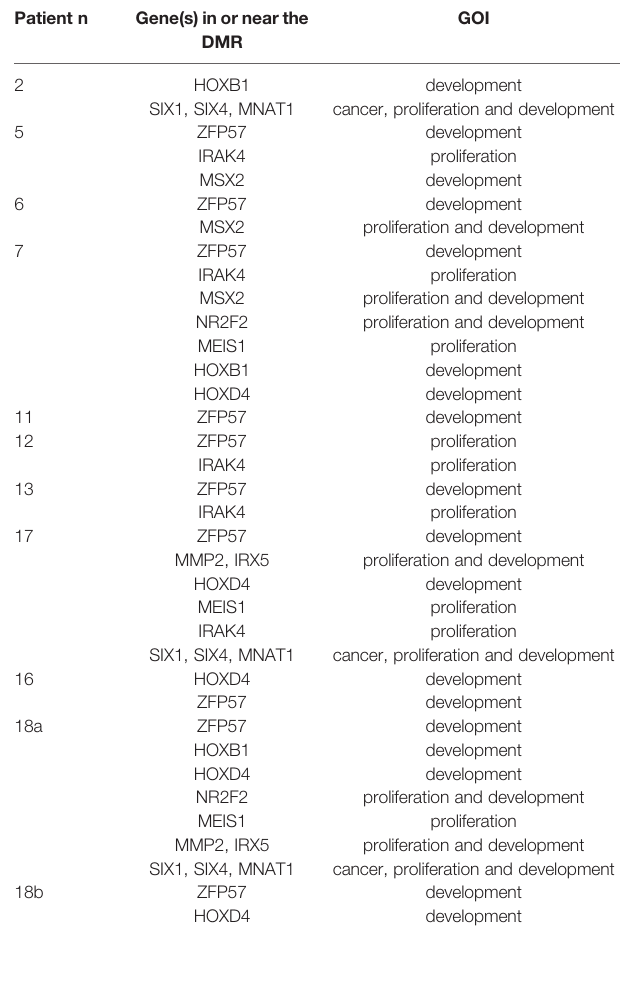
TABLE 2 | GOI close to signi fi cant DMRs elicited by the comparison between cases of same histology with controls. Histology